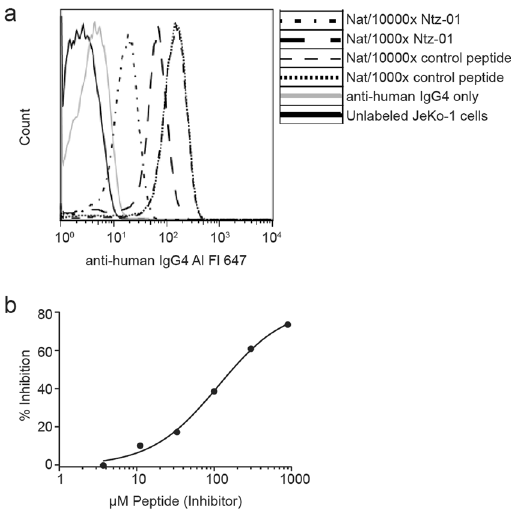
Figure 2. Characterization of Ntz-01 binding epitope ( a ) Ntz-01 competition with CD49d + JeKo-1 cells for natalizumab binding. ( b ) Ntz-01 inhibition of natalizumab capture by anti-Id ELISA. One representative experiment is shown for